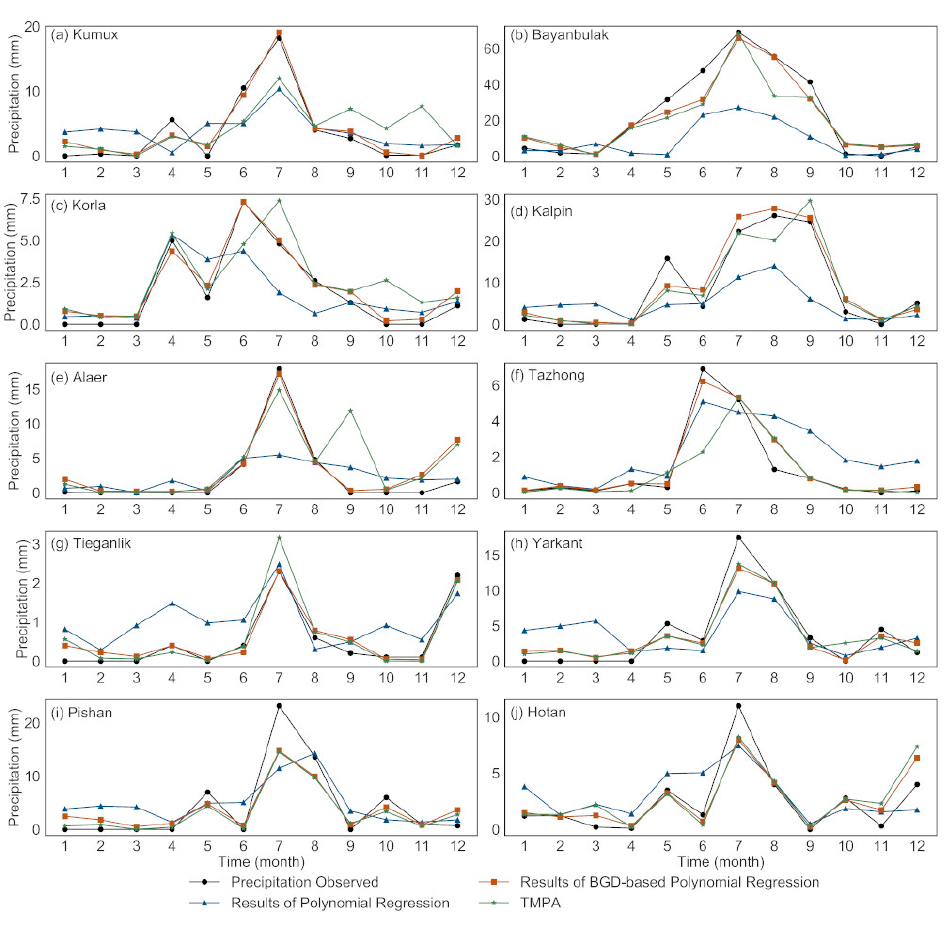
Figure 5. The comparison of the change in precipitation of 2001. ( a – j ) are the variations of Kumux, Bayanbulak, Korla, Kalpin, Alaer, Tazhong, Tieganlik, Yarkant, Pishan,